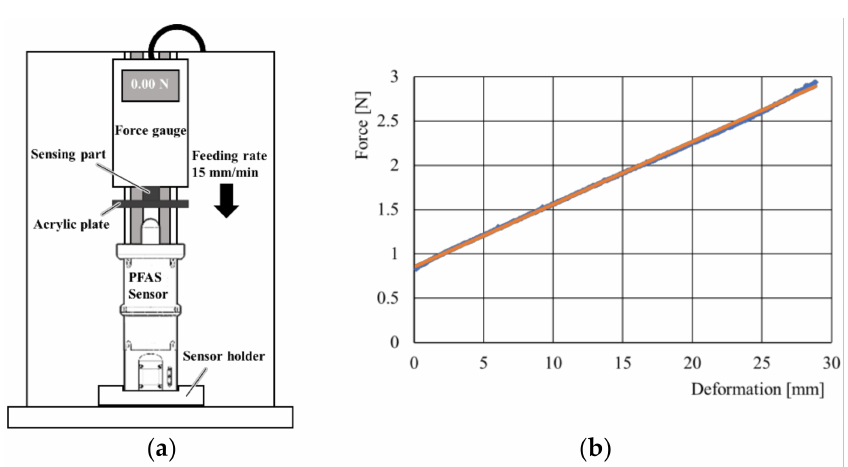
Figure 7. ( a ) Experimental setup for calibration test; ( b ) Force–deformation characteristic curve. The blue points represent raw data, whereas the red line represents the regression